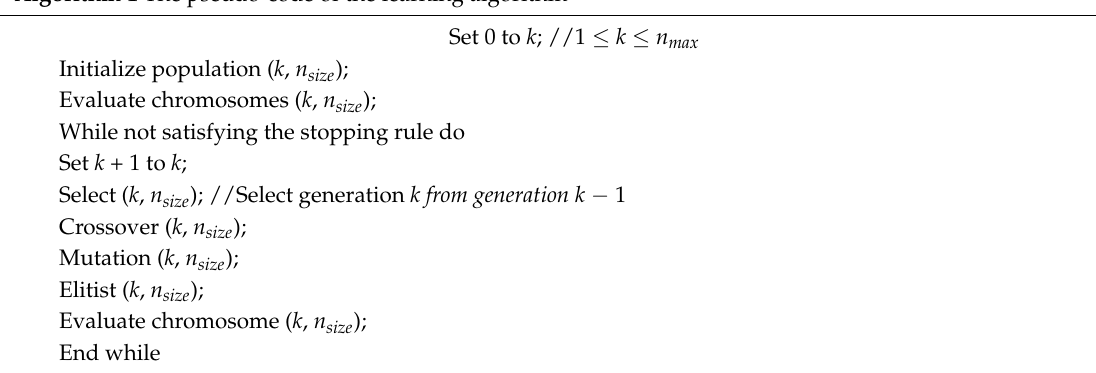
Algorithm 1 The pseudo-code of the learning